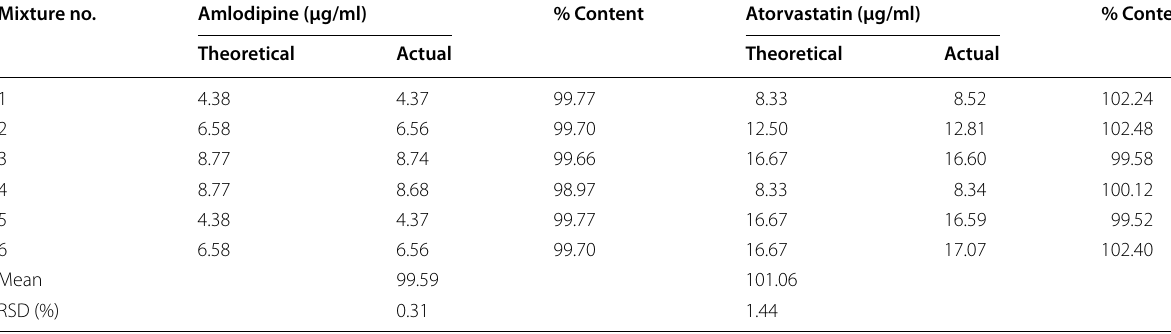
Table 6 Absorbance factor method recovery results Mixture